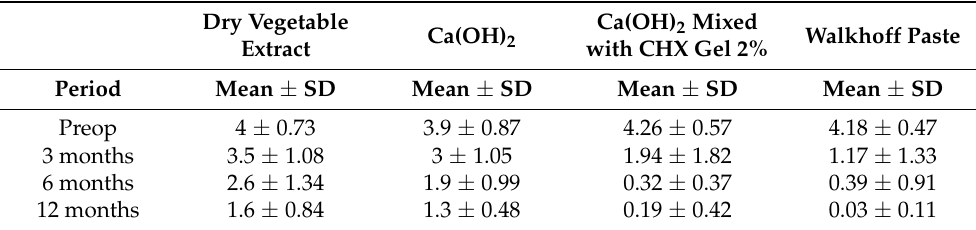
Table 2. Mean values and standard deviation of the PAI, at different time intervals, for the group with